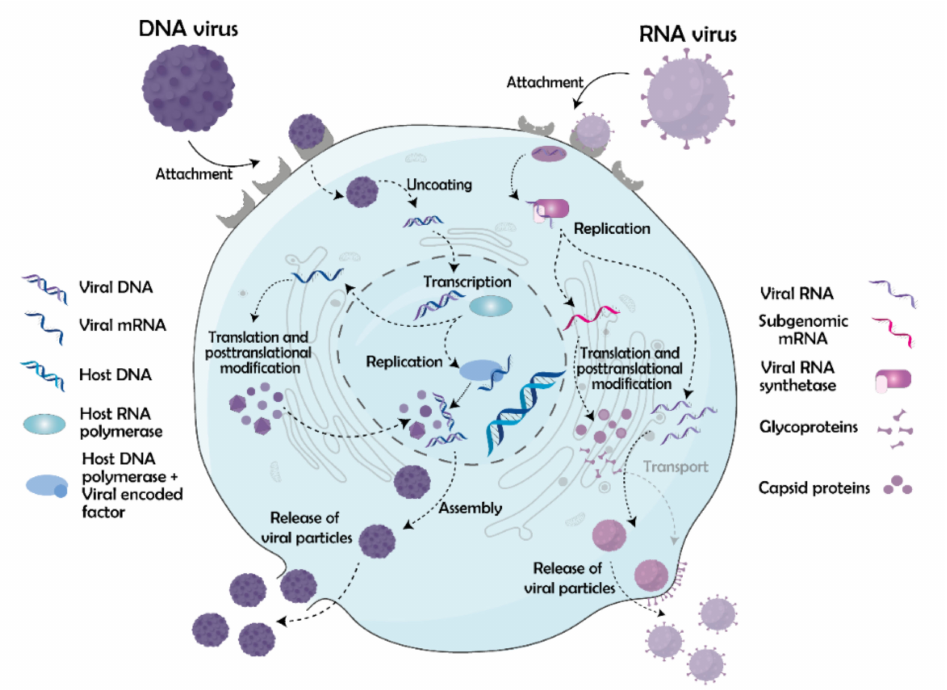
Figure 2. The life cycle of non-enveloped DNA and enveloped RNA viruses excluding retroviruses. (1) Life cycle of non-enveloped DNA viruses: a virus attaches to a specific cell surface receptor and enters the host cell. Subsequently, the virus exposes its DNA, which is transported to the cell nucleus and is replicated. Next, the DNA is transcribed into RNA followed by translation to viral proteins, which are then post-transcriptionally modified. The viral proteins and replicated DNA assemble into novel viral particles, which are then released from the host cells via disruption of the cell plasma membrane. (2) Life cycle of enveloped RNA viruses: a virus attaches to a specific cell surface receptor and enters the host cell (not indicated in the scheme) or inserts the RNA through the plasma membrane (indicated). This RNA is replicated via viral RNA synthetase and viral proteins are translated and post-transcriptionally modified. Next, the viral particles are released via exocytosis and are enveloped by the plasma membrane containing glycoproteins on its